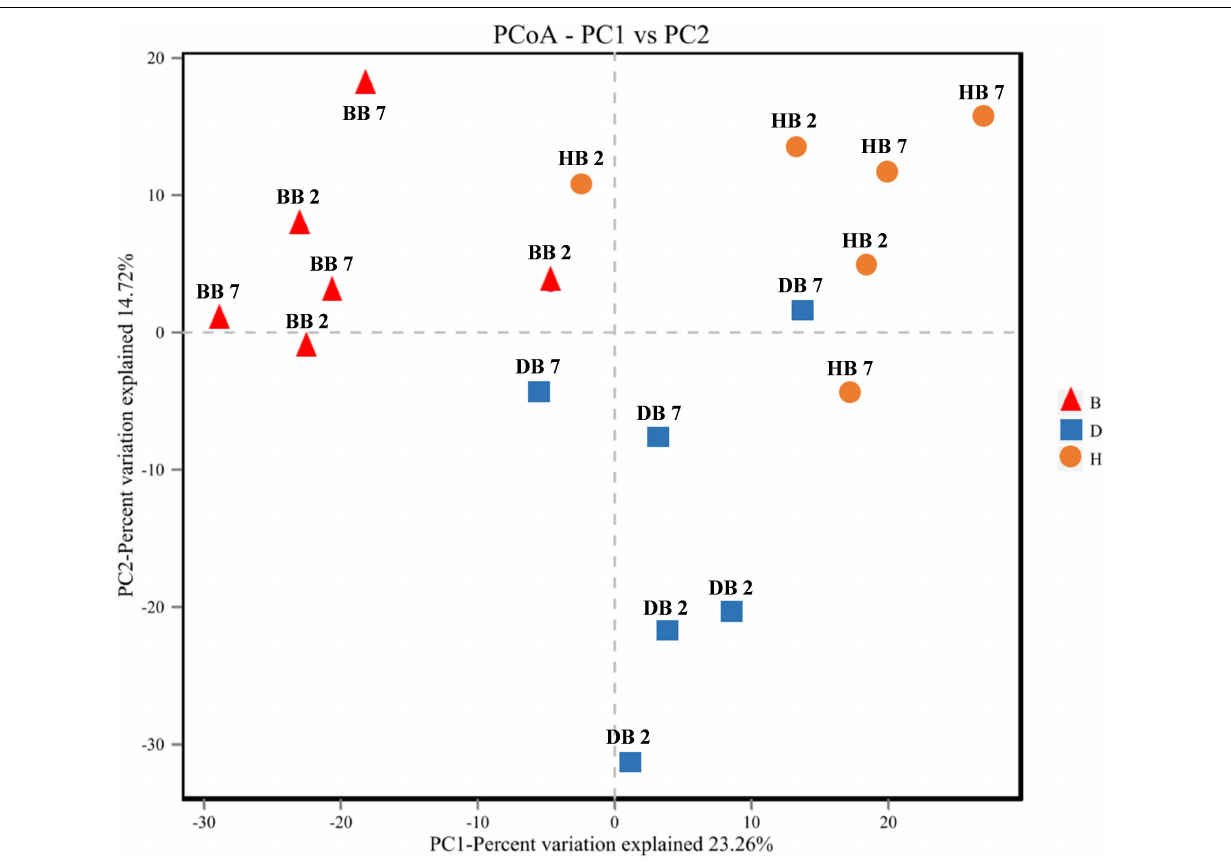
FIGURE 5 | Principal coordinates analysis (PCoA) of fungal diversity in oat seed samples from three region